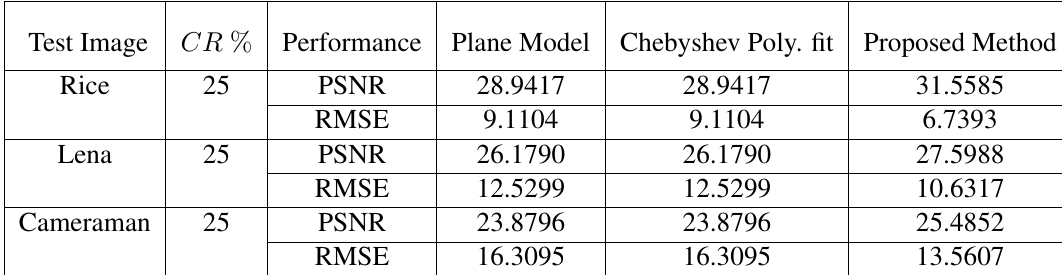
Table 4: Performance comparison with Polynomial fitting model and Chebyshev polynomial surface fit model in the case of 2 × 2 blocks.